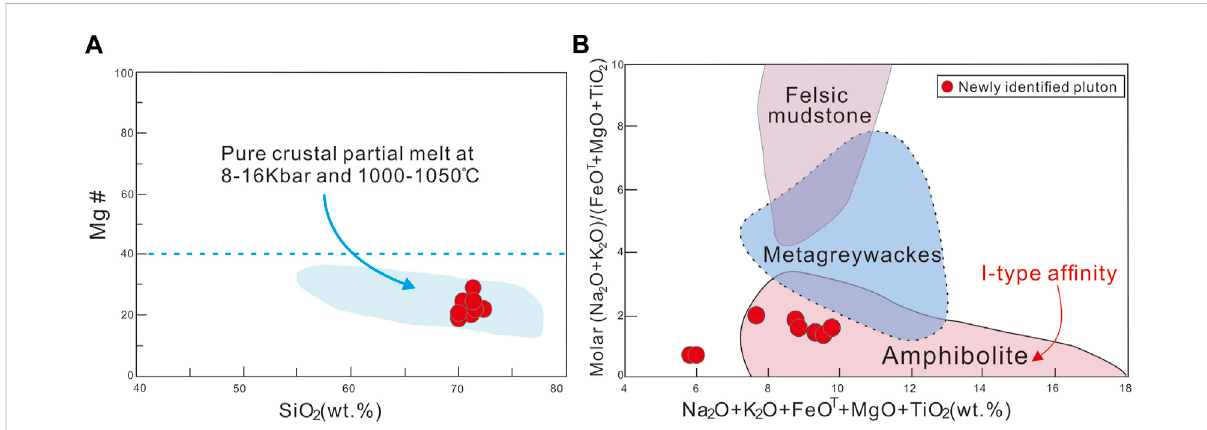
FIGURE 10 (A) SiO 2 vs. Mg# (pure crustal fi eld is based on Rapp and Waston, 1995, after Meng et al., 2021); (B) Na 2 O+K 2 O+FeO T +MgO+TiO 2 vs. molar (Na 2 O+K 2 O)/(FeO T +MgO+TiO 2 ) diagram (after PatinoDouce,